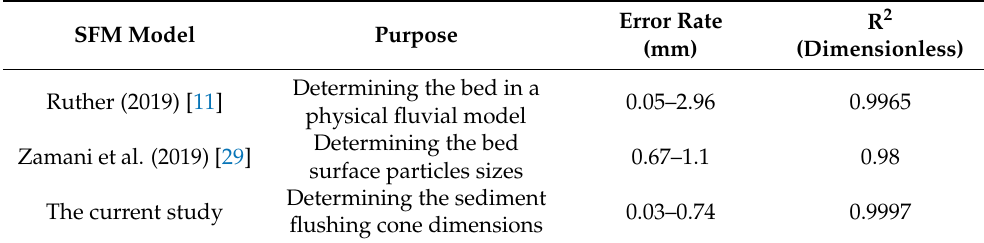
Table 4. Data accuracy comparison between the different SFM